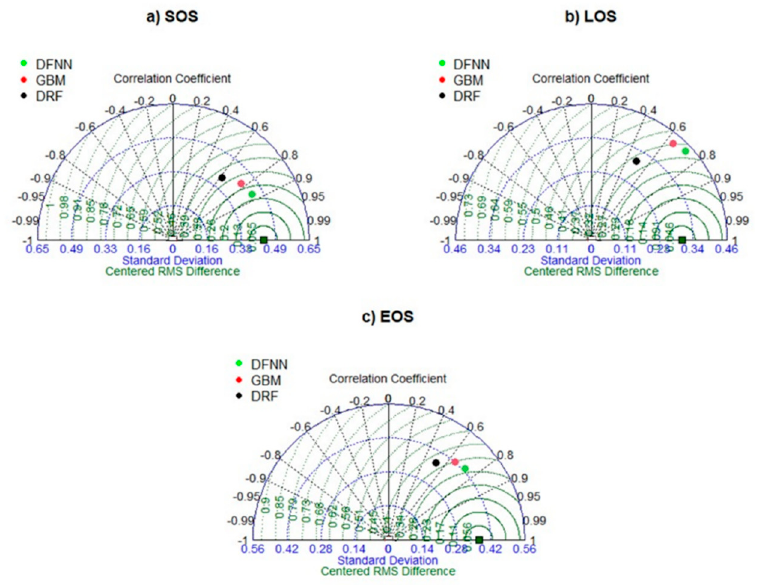
Figure 8. Taylor diagram showing the performance of the models during different crop phenology stages.